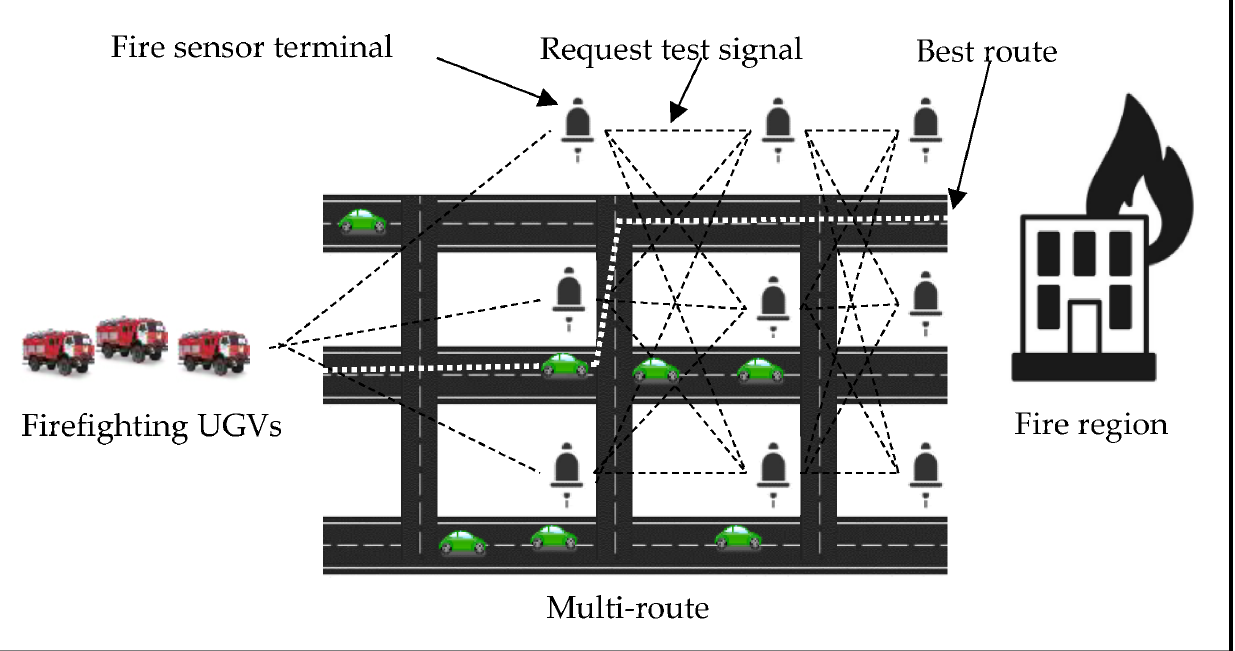
Figure 1. ACO scenario of the VANET for the firefighting UGVs, which depends on the throughput parameter to select the optimal route.